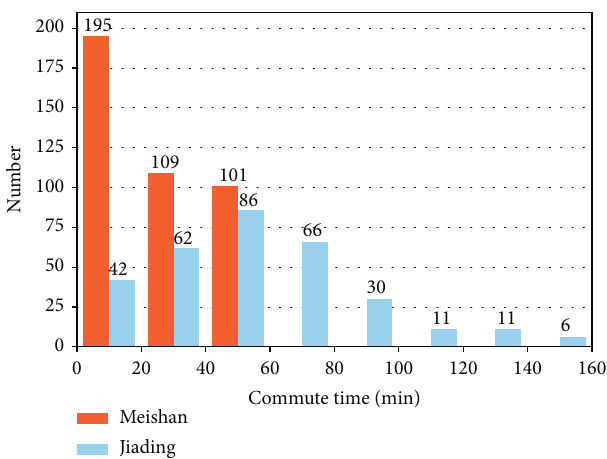
Figure 2: Distribution of commuting time of the sample in the two